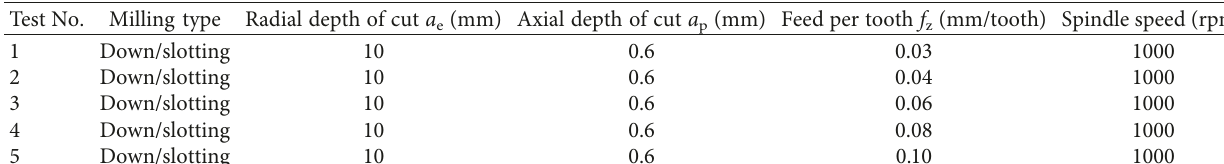
Table 2: Cutting conditions for the cutting force coefficients identification.